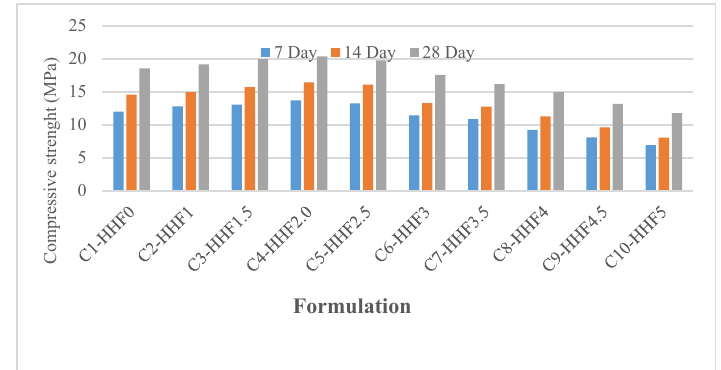
Figure 1. Compressive strength of concrete human hair fiber.